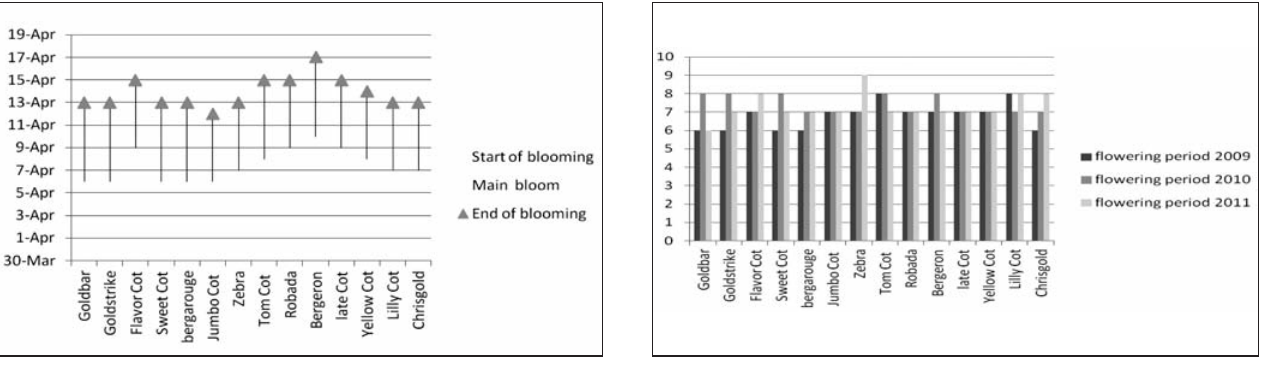
Fig 2: Time of start, main and end of blooming 14 apricot varieties through 2010 seasons